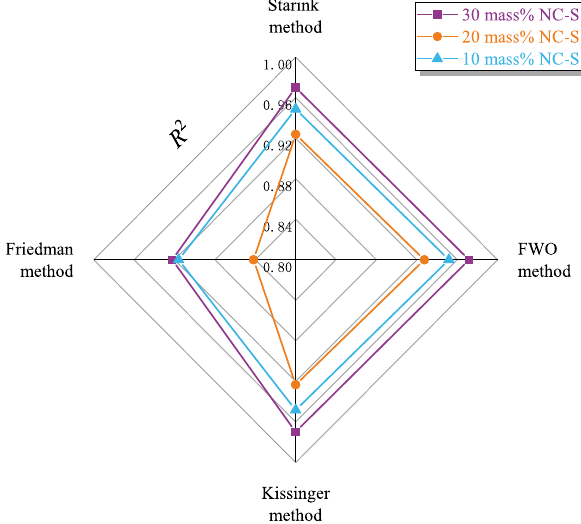
Figure 7. Comparison of four kinetic models’ R 2 via TG data.